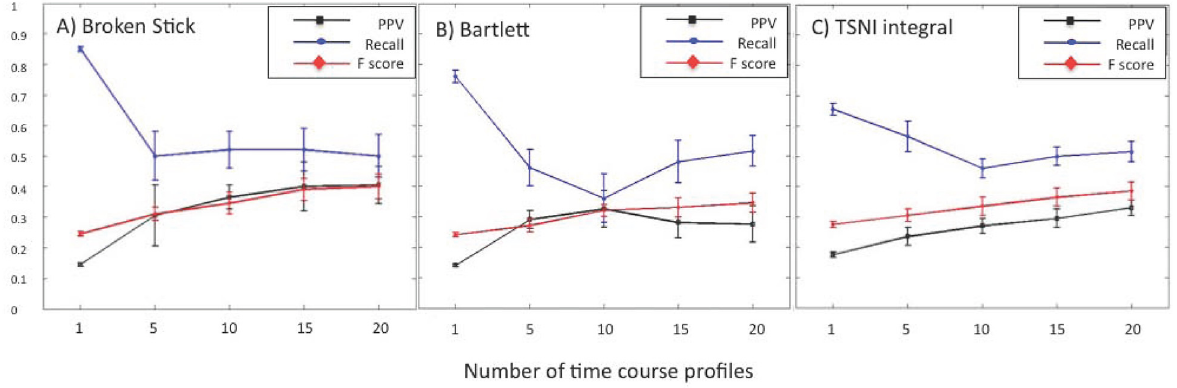
Fig 2. Median performance calculated across subsets from 10 different 10-node simulated networks recovered using (A) Broken stick (B) Bartlett ’ s and (C) TSNI integral methods applied to groups of time courses . Each network was used to generate groups of 1, 5, 10, 15 and 20 simulated time courses each sampled at 50 time points. All simulations included 20% experimental